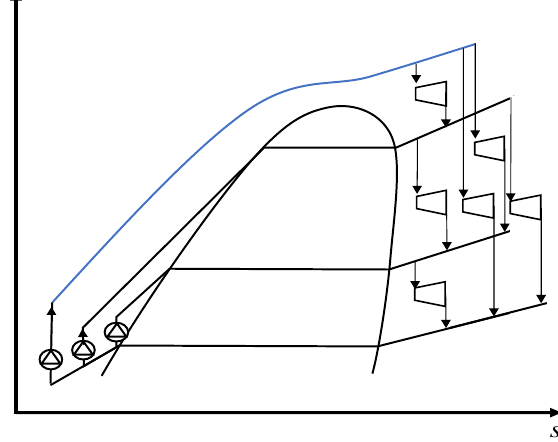
Figure 10. Multi-objective optimization of the ORC superstructure.